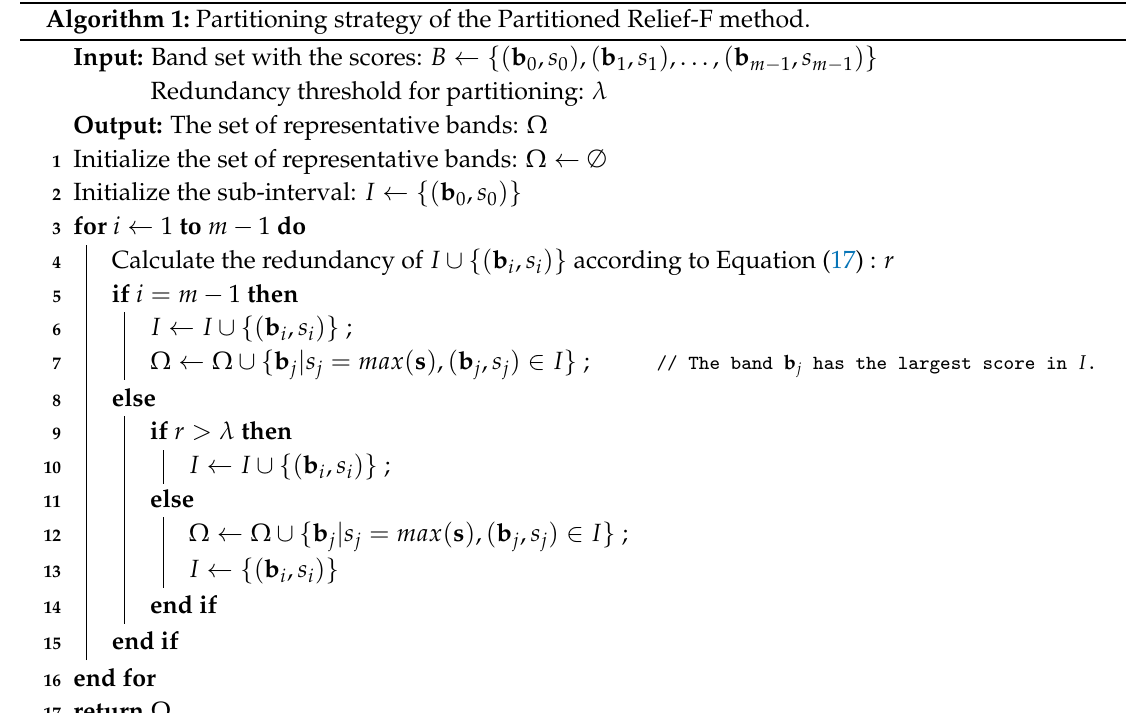
Algorithm 1: Partitioning strategy of the Partitioned Relief-F